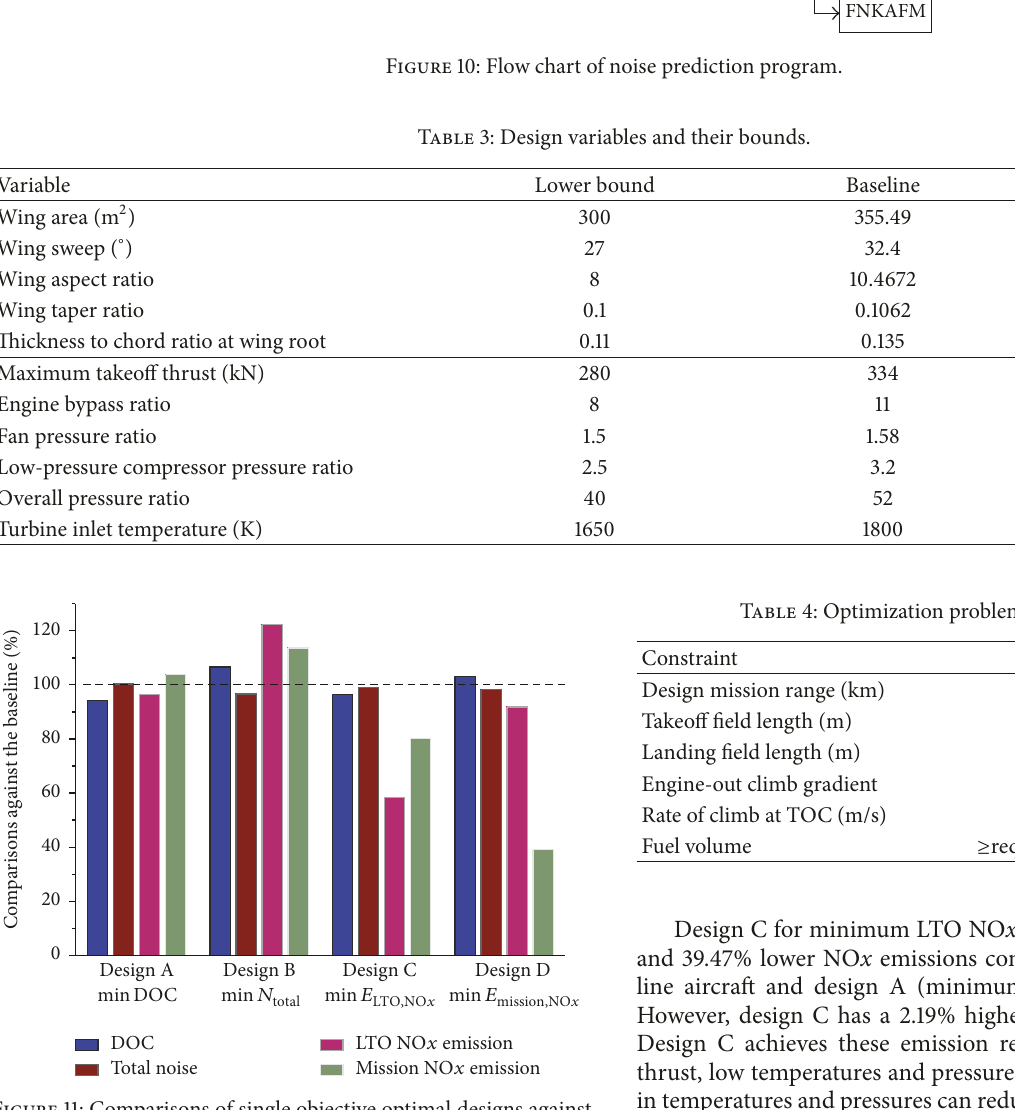
Figure 11: Comparisons of single objective optimal designs against the baseline.